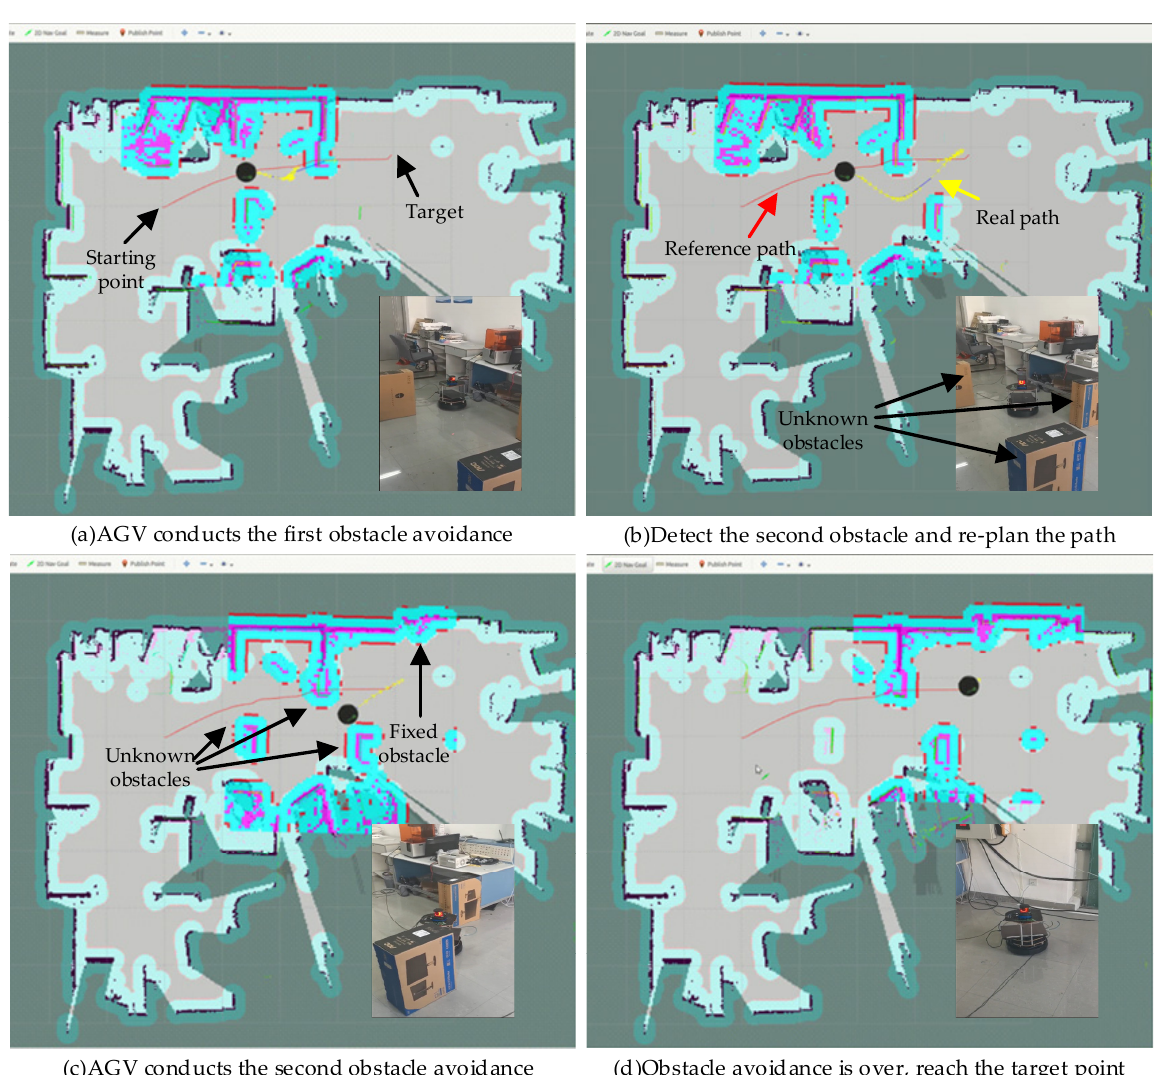
Figure 8. The process of AGV movement in the environment with unknown static obstacles.